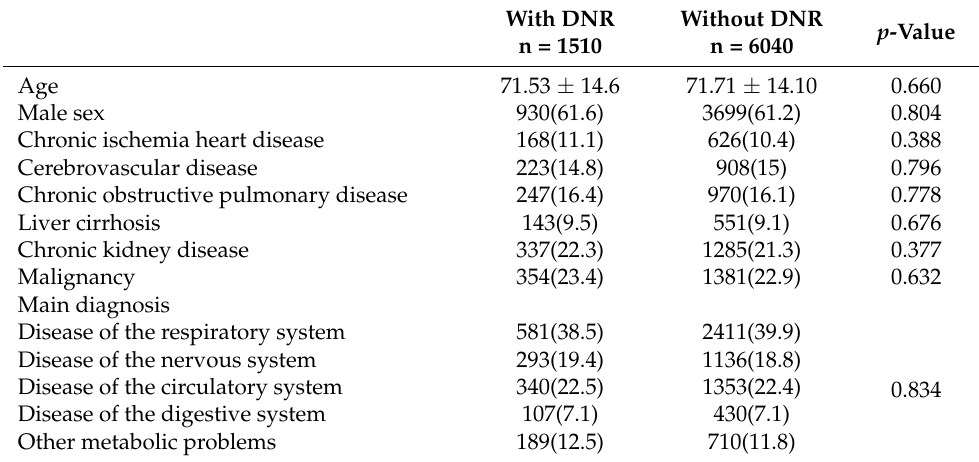
Table 1. Clinical characteristics of patients after 1:4 propensity score matching.